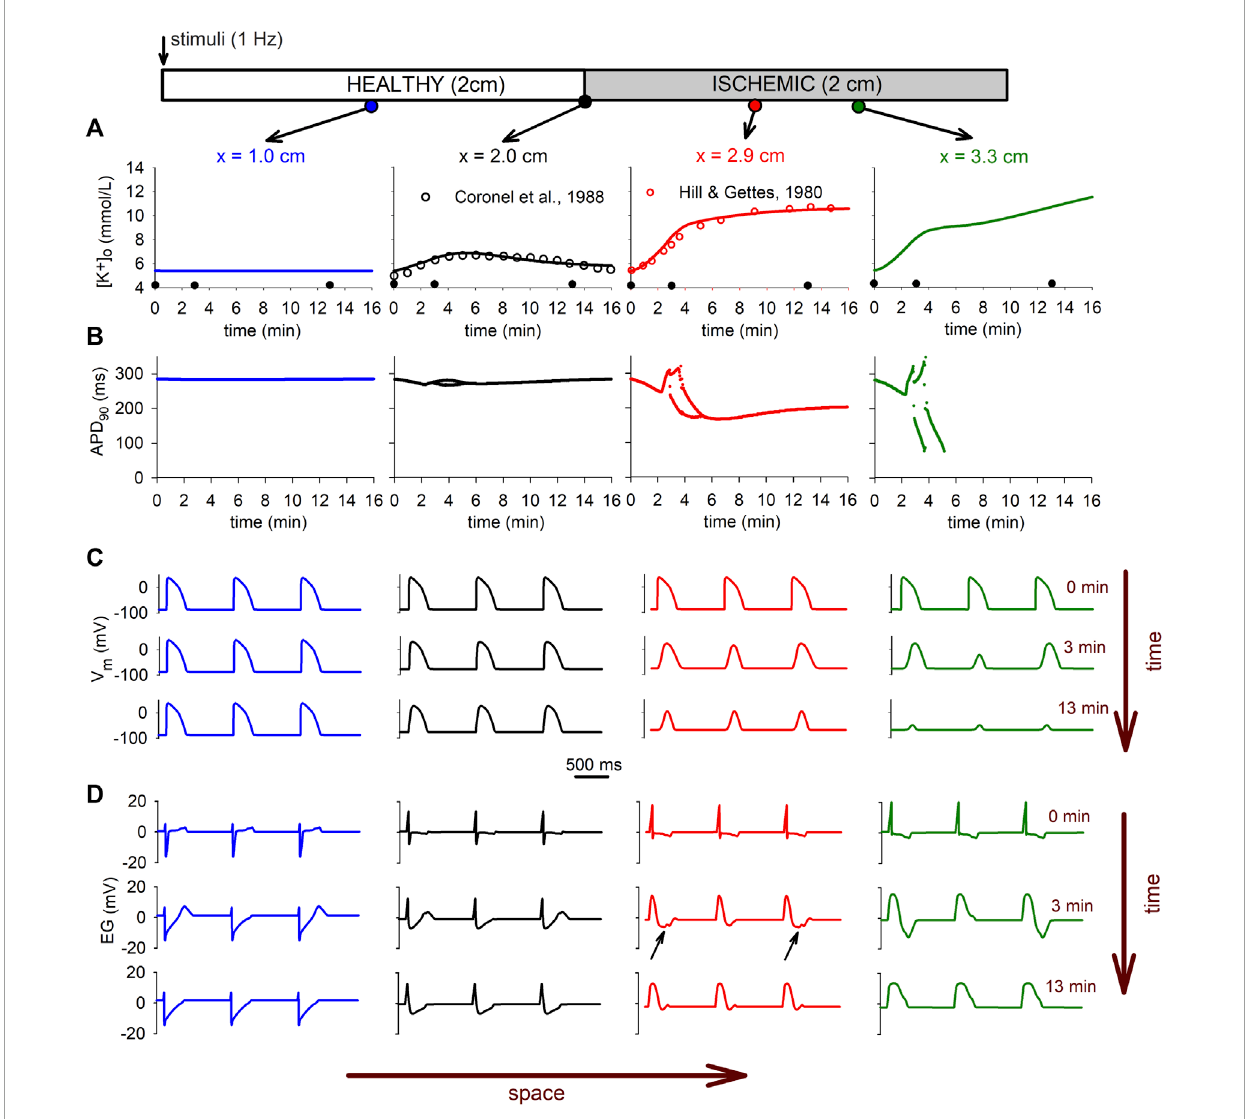
FIGURE 8 Electrophysiological manifestations of the extracellular potassium accumulation in tissue. (A) : time course of the [ K + ] o at different locations in the tissue. Model results at the BZ are compared with experimental results (Coronel et al., 1988). (B) : Evolution of the APD 90 during acute ischemia in different locations. (C) Evolution of the AP during ischemia at different positions in the tissue. (D) : Changes in the electrograms with ischemia at different locations in the tissue. Arrows indicate the depression in the ST segment due to ischemia in the altered region.